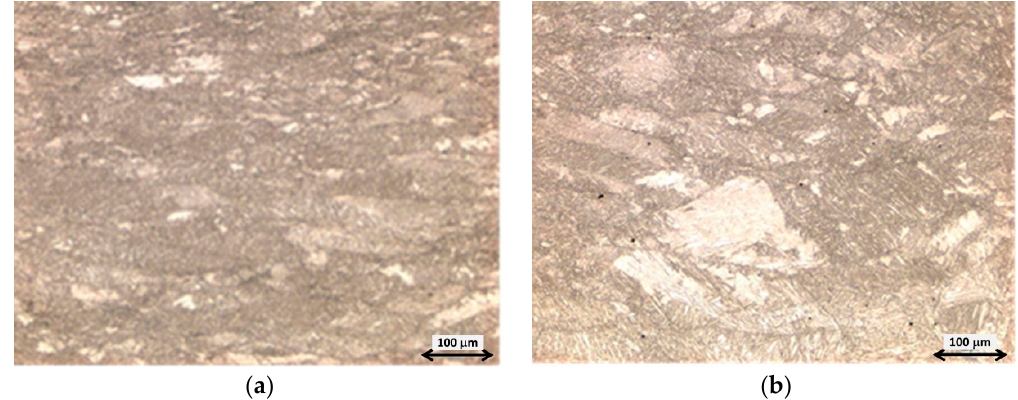
Figure 6. Microstructure before the next to last deformations for the Nb steel ( a ) and the NbMo steel ( b ).